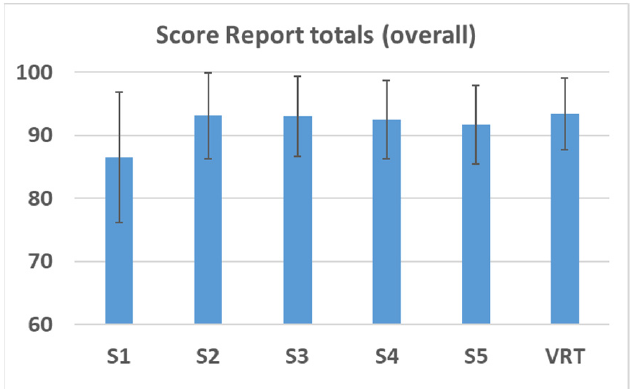
Figure 11. Score report totals.